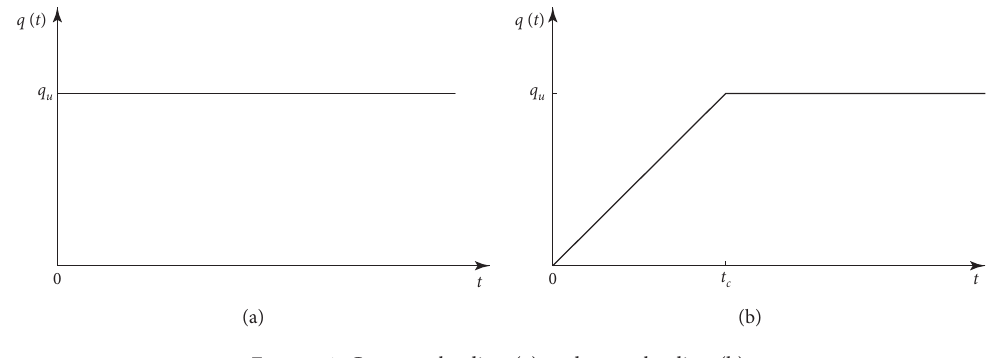
Figure 4: Constant loading (a) and ramp loading